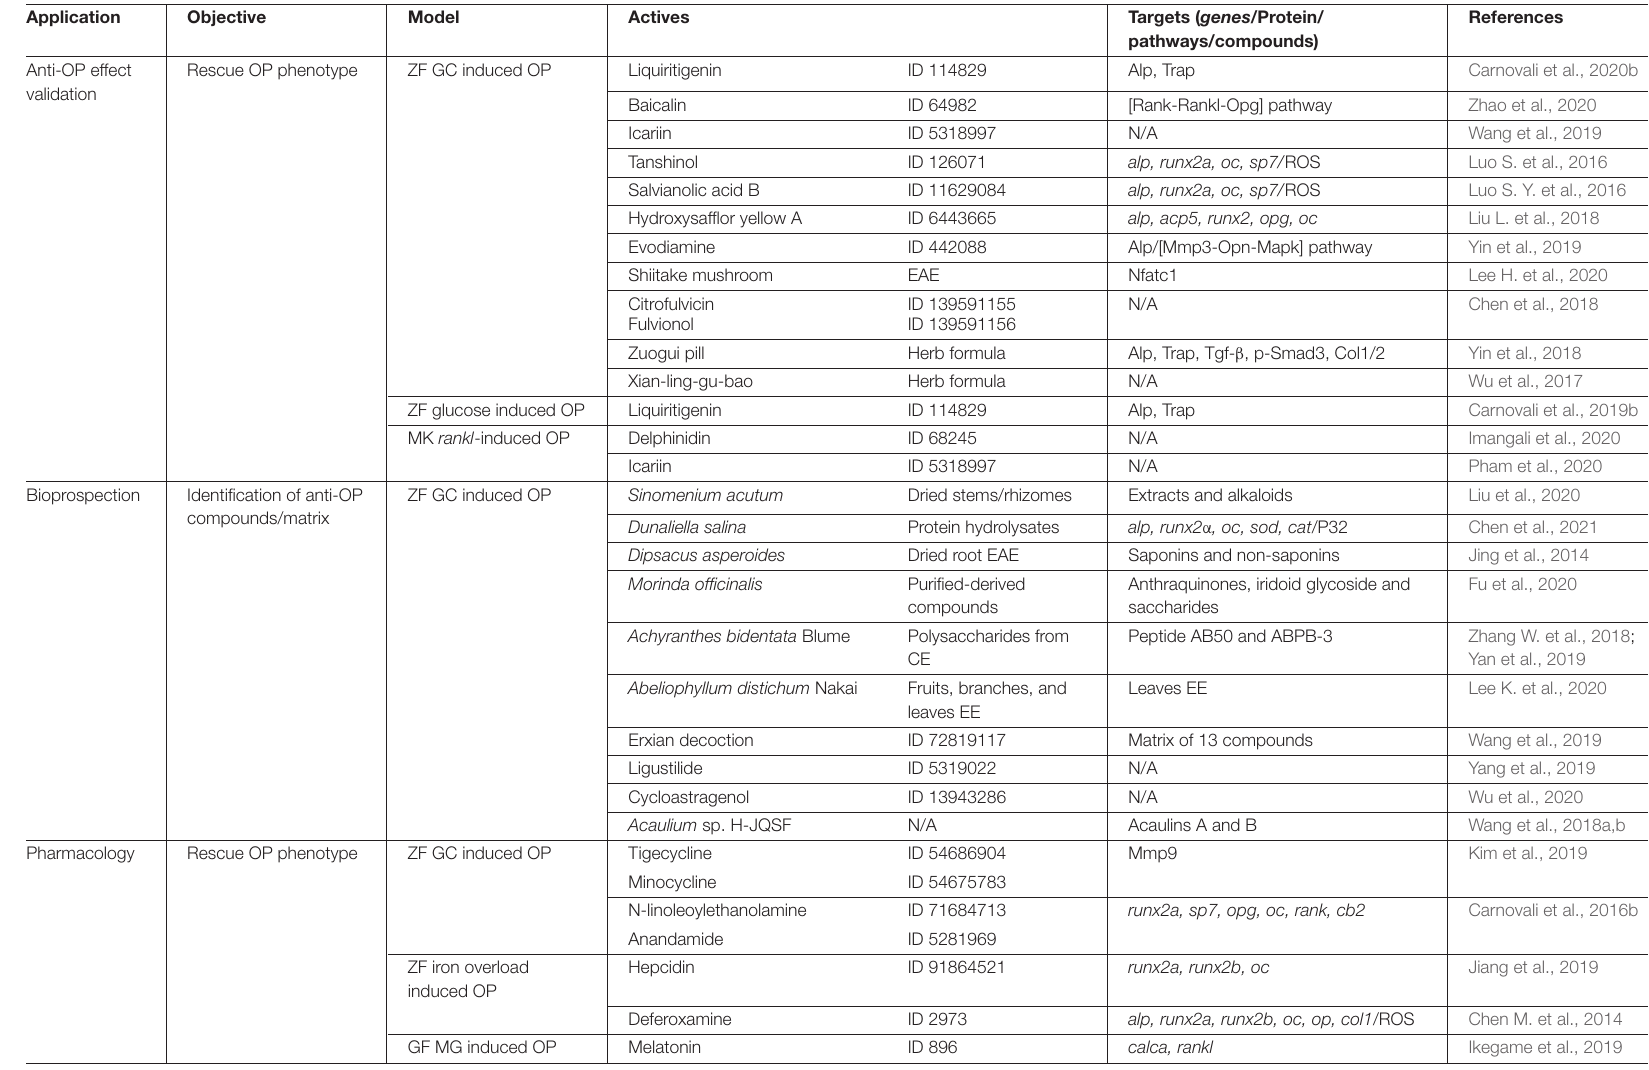
TABLE 2 | Fields of application of teleost OP